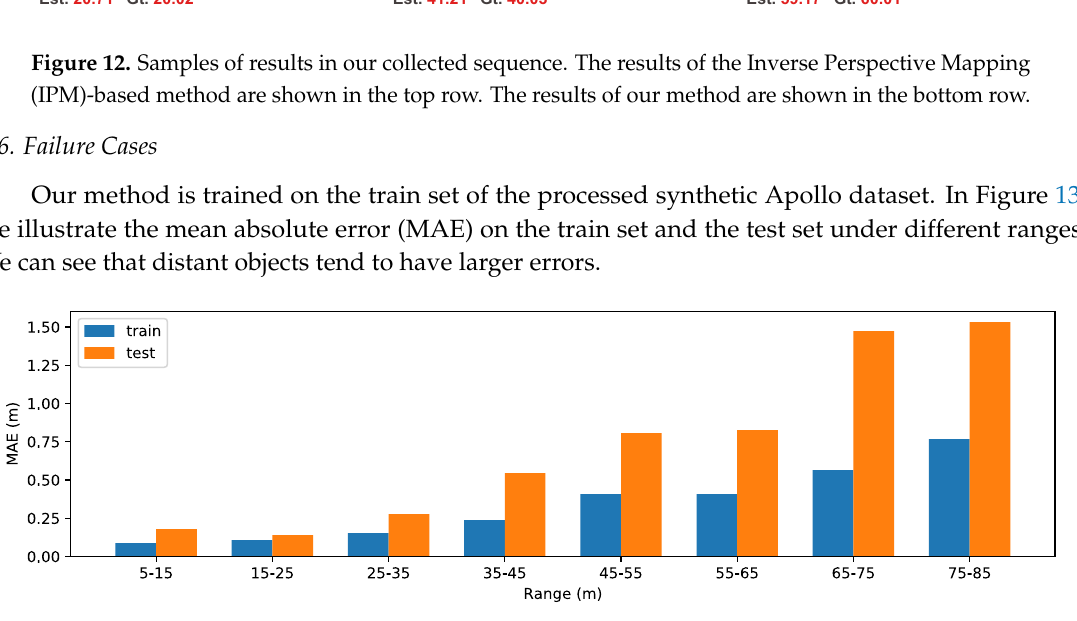
Figure 13. Mean absolute error (MAE) (in m) on the train set and test set under different ranges.